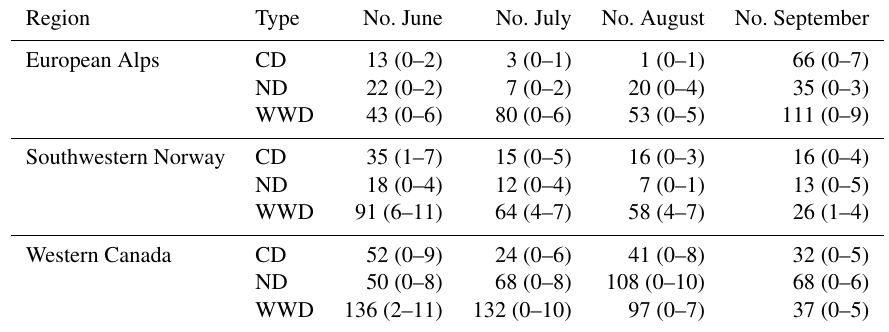
Table 4. Number of CD, ND, and WWD events. The numbers in between parentheses indicate the range of number of events for the individual